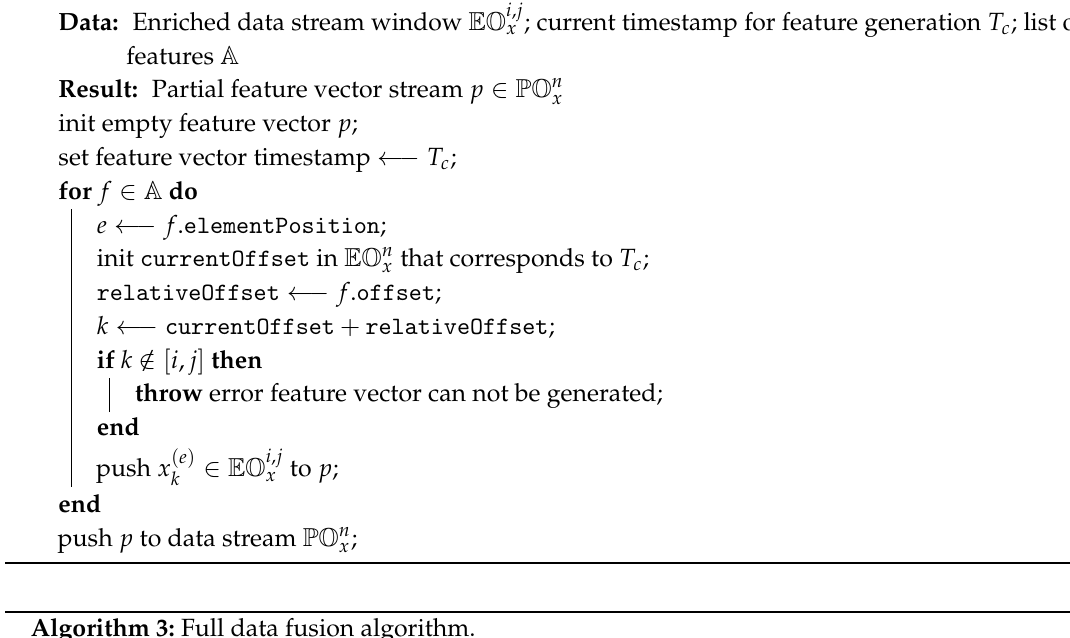
Algorithm 3: Full data fusion